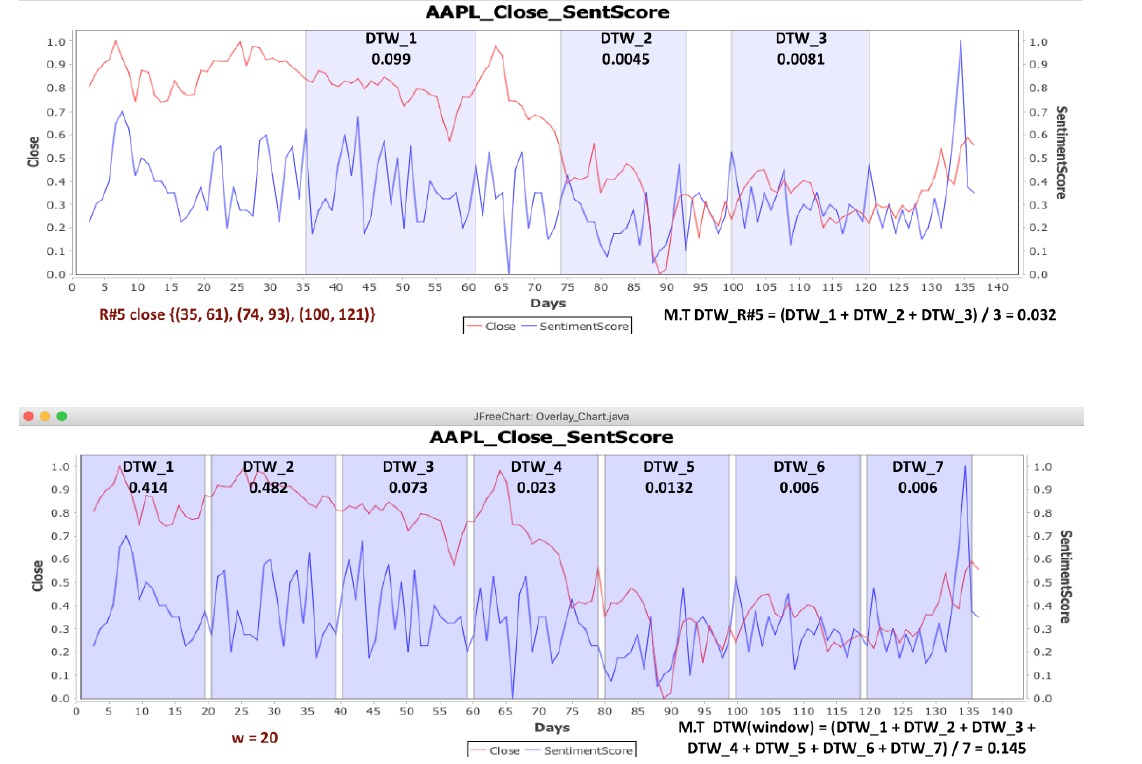
Figure 3. Testing the validity of a rule against random